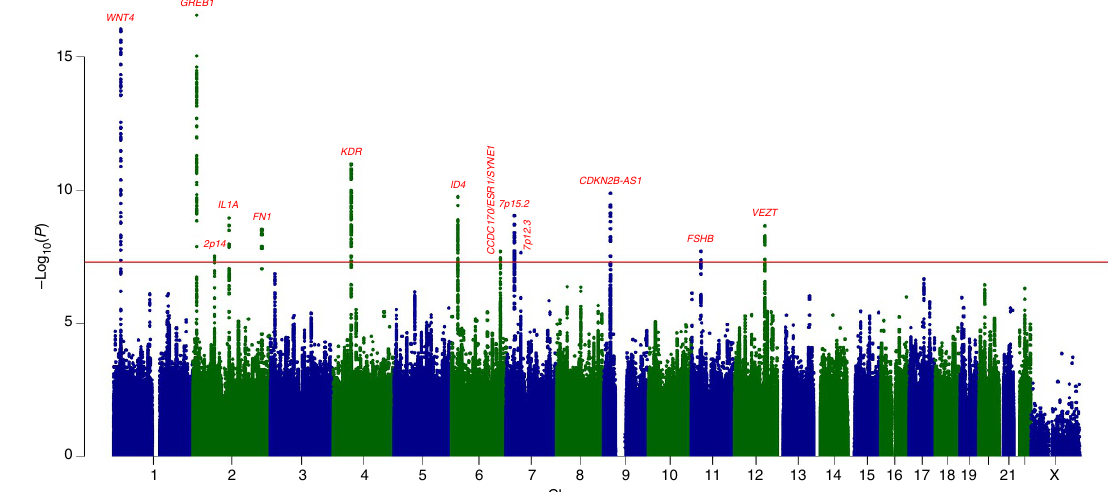
Figure 1 | Manhattan plot for genome-wide associations with endometriosis. Data are based on GWA meta-analysis of all endometriosis cases. The horizontal axis shows the chromosomal position, and the vertical axis shows the significance of tested markers combined in a fixed-effects meta-analysis. Markers that reached genome-wide significance ( P o 5 (cid:2) 10 (cid:3) 8 ) are highlighted. Table 1 | Summary of the GWA meta-analysis results for 14 genome-wide significant loci.